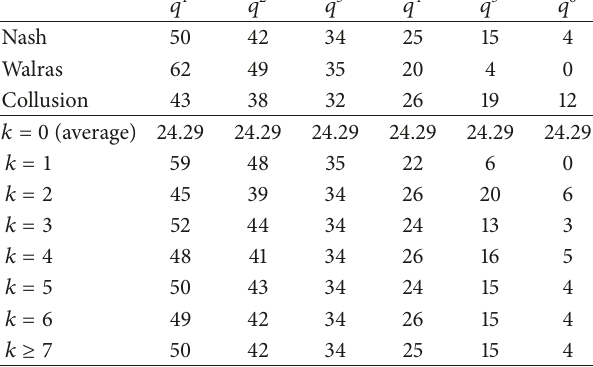
Table 1: The first three rows present the Nash, Walras, and collusive quantities for each period. The fourth row gives the average production quantity for a level-0 for each period. The remaining rows give the trajectories for different level- 𝑘